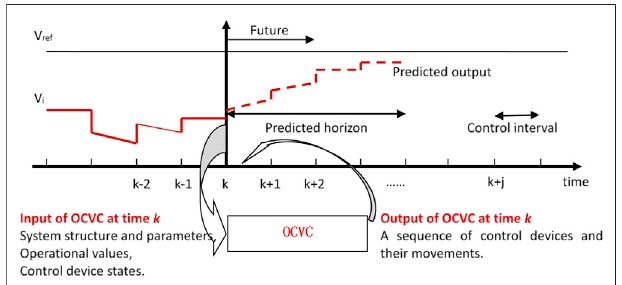
FIGURE 1 | MPC-based coordinated voltage